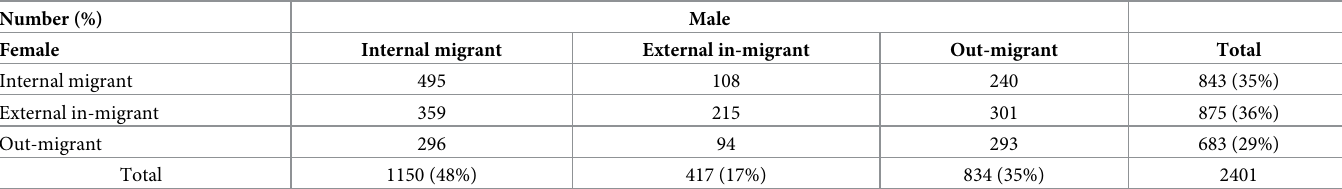
Table 1. Types of migration in sexual partnership formation by